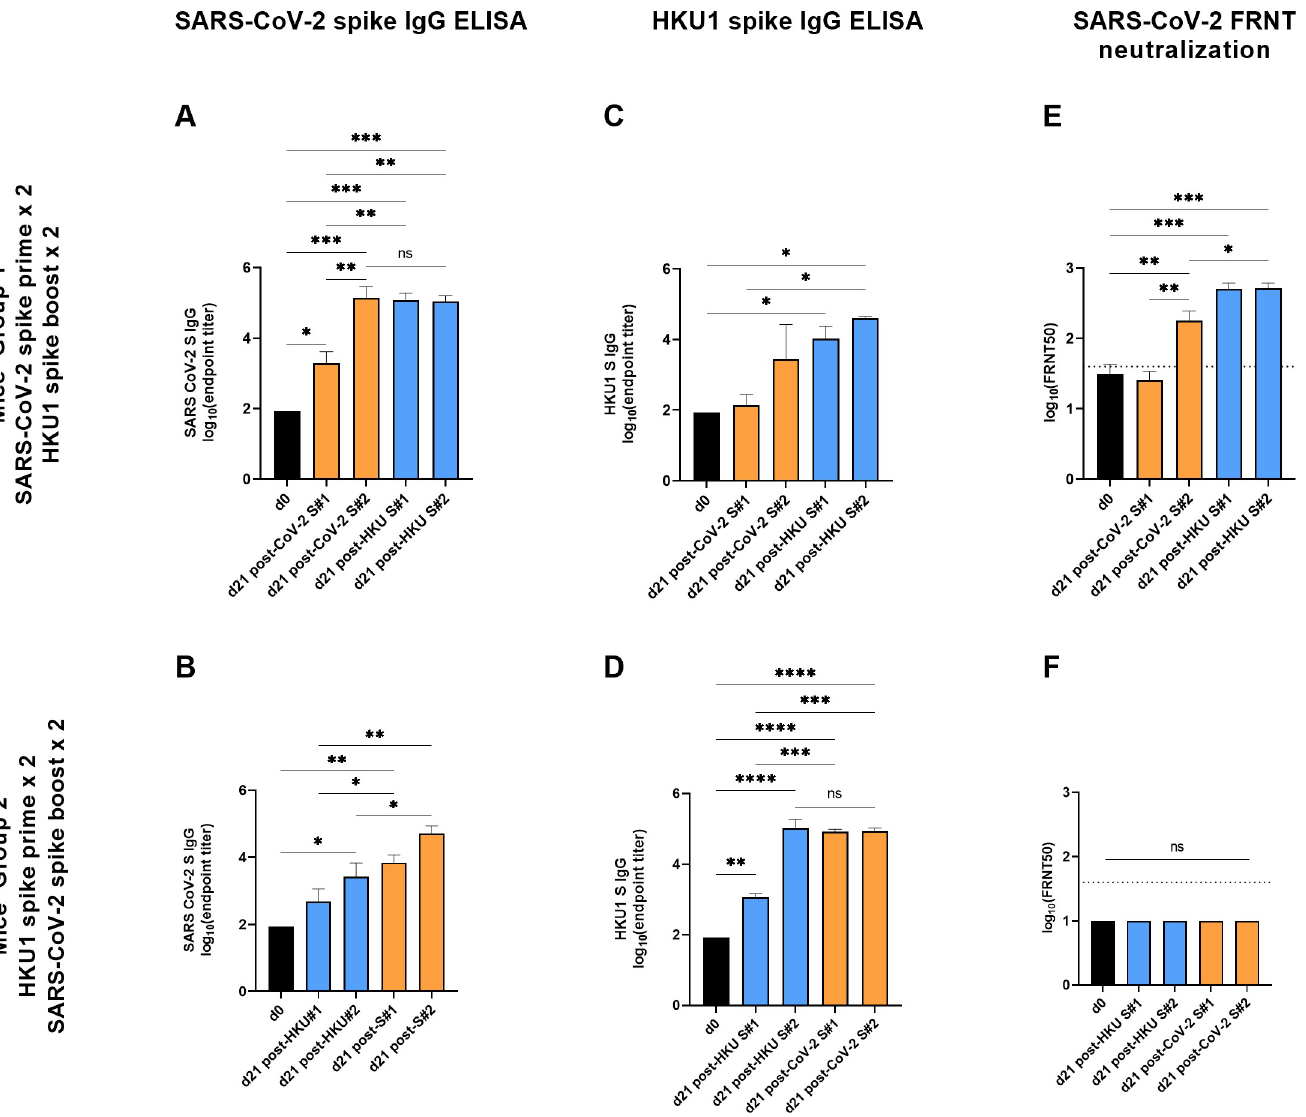
Fig 2. Priming mice with HKU1 spike protein prior to boosting with SARS-CoV-2 spike protein completely impeded the development of SARS-CoV-2 neutralizing antibodies. SARS-CoV-2 (A,B) and HKU1 (C,D) full-length spike IgG binding and SARS-CoV-2 neutralizing (E, F) antibodies in mice are shown as log (end-point titer). Group 1 was primed with two doses of alum-adjuvanted SARS-CoV-2 spike and boosted with two doses of alum-adjuvanted HKU1 spike (A, C, E). Group 2 received the reciprocal regimen of HKU1 spike prime and SARS-CoV-2 spike boost (B, D, F). � P < 0.05; �� P < 0.01; ��� P < 0.005; ���� P < 0.001.